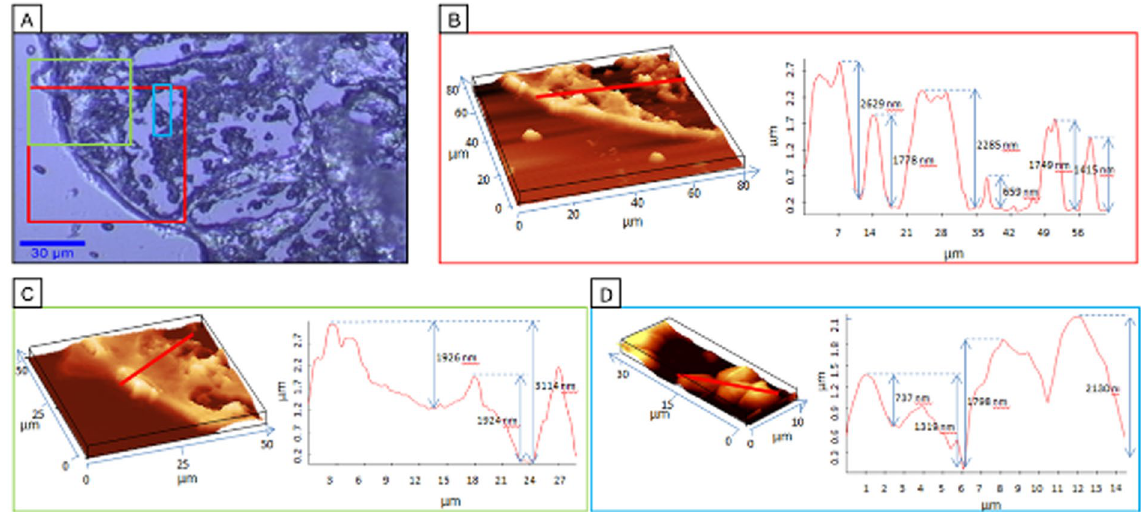
Figure 4. AFM imaging of human brain clot of a large vessel origin. ( A ) White–light optical image (100 × ) of the cross section of fibrin–predominant clot (marked in Fig. 2A) with the investigated ROIs labeled with red, green and blue; ( B–D ) the AFM topography images in 3D view and topography profile according to red line for presented in A